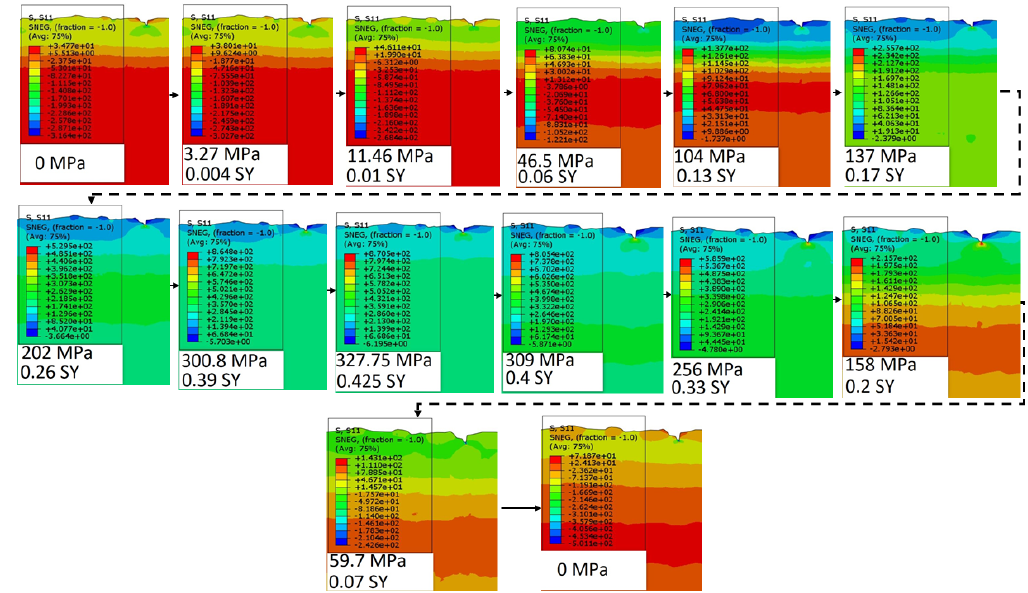
Figure 15. The stress distribution at different time steps of the loading without peak load and with the effect of residual stress.